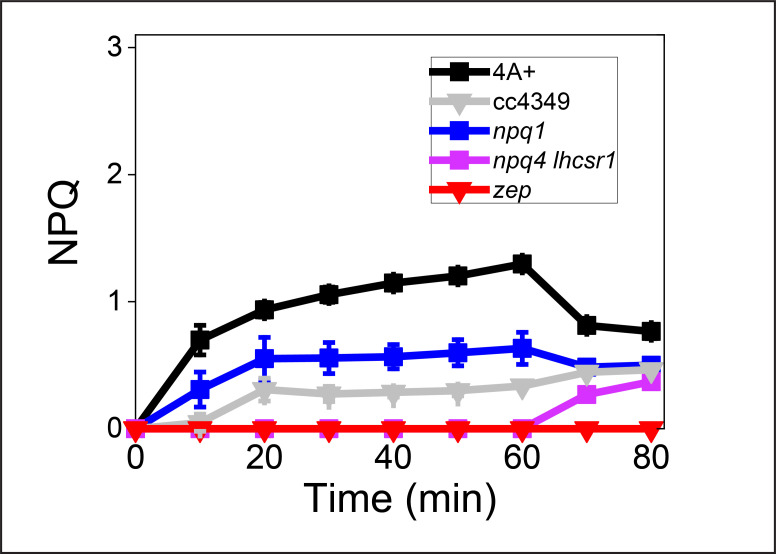
Nonphotochemical quenching (NPQ) induction in low-light (LL) acclimated Chlamydomonas reinhardtii cells.NPQ induction kinetics measured upon 60 min of high light (HL; 1500 μmol m−2s−1) followed by 20 min of dark recovery. The results reported are representative of three independent biological replicates for each genotype in LL or HL. Error bars are reported as standard deviation (n = 3).